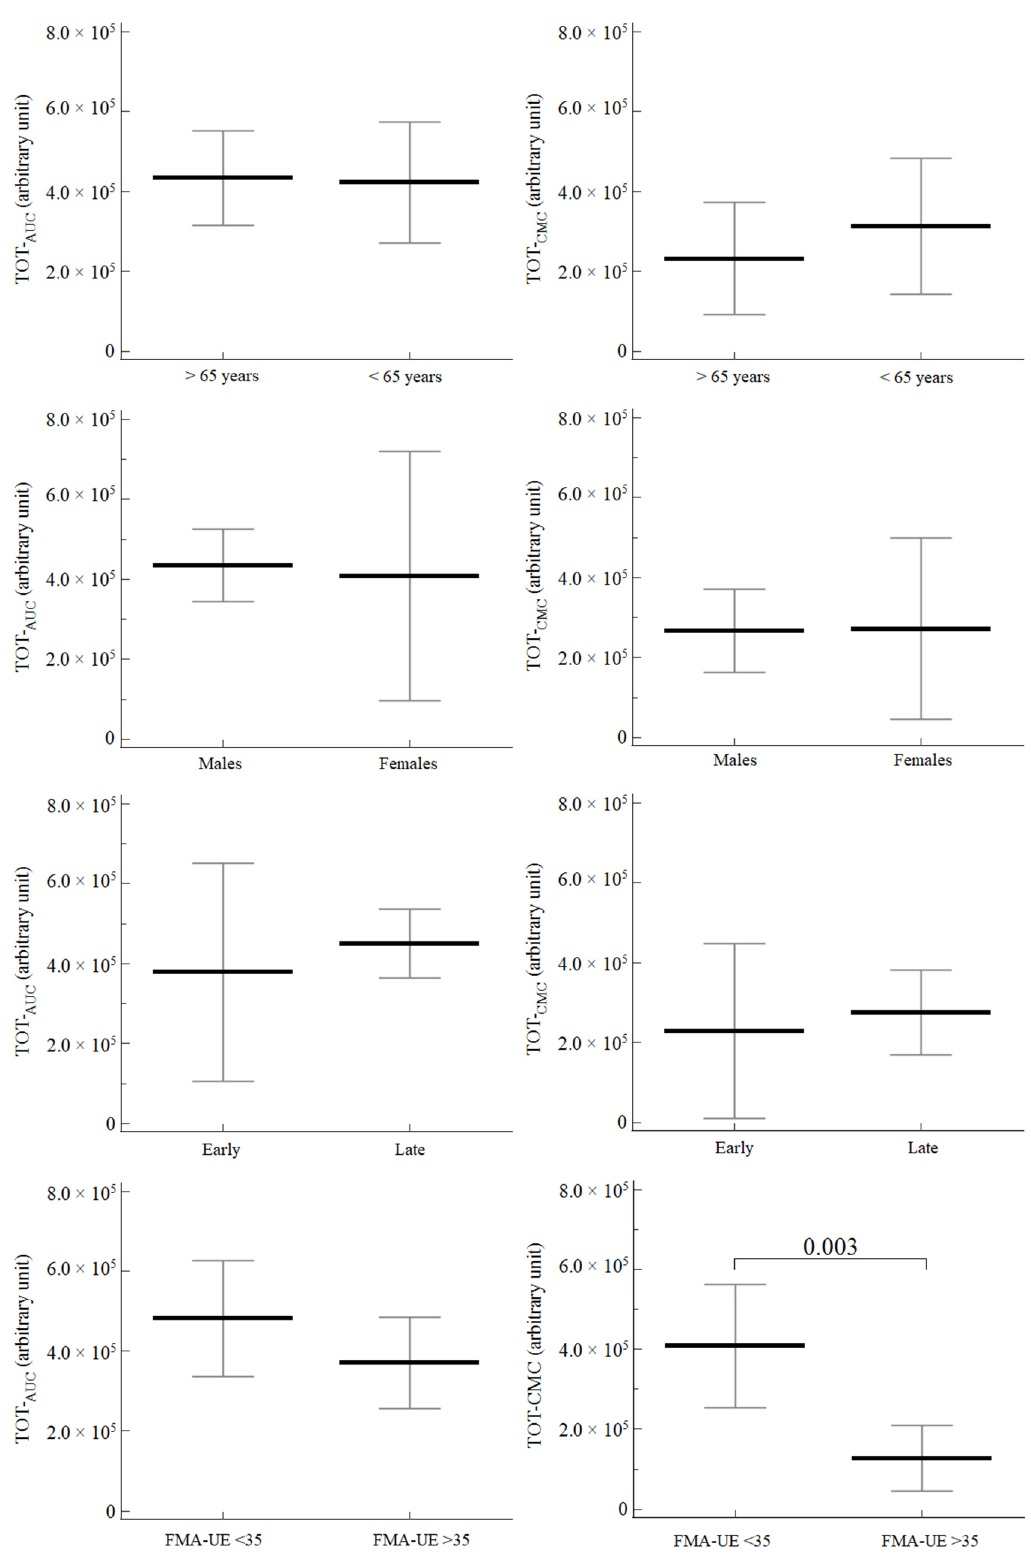
Figure 2. Baseline comparison of values of TOT- AUC and TOT- CMC according to age, sex, distance from stroke onset (early or late) and FMA-UE score. Data are reported as mean (95% confidence interval).